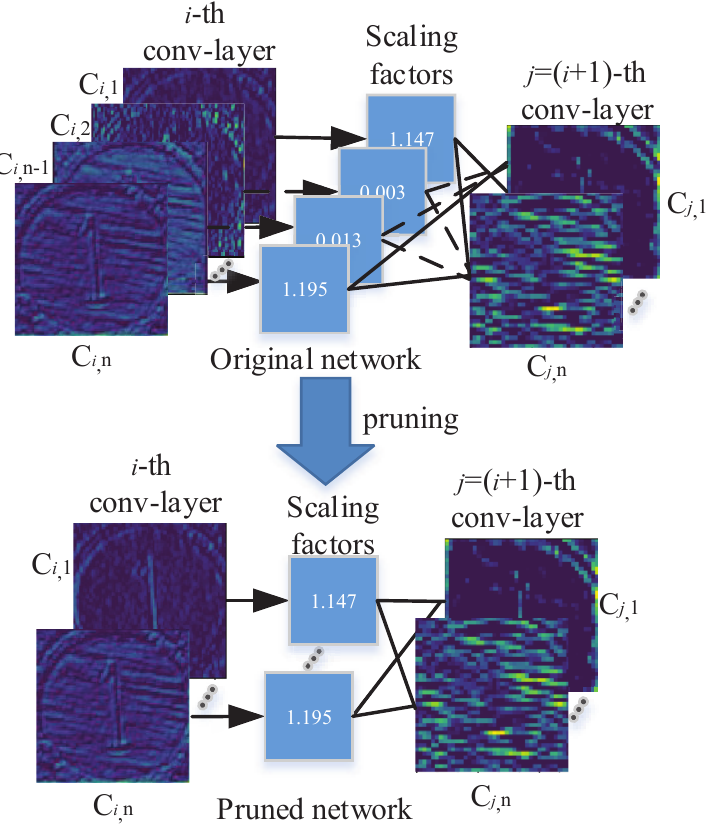
Figure 3. We use the trainable parameter γ in the batch normalization layer as the scaling factor and each channel corresponds to a scaling factor. After sparse these scaling factors, the channels with small scaling factors are taken as trivial channels and removed. After pruning, we can obtain a slim